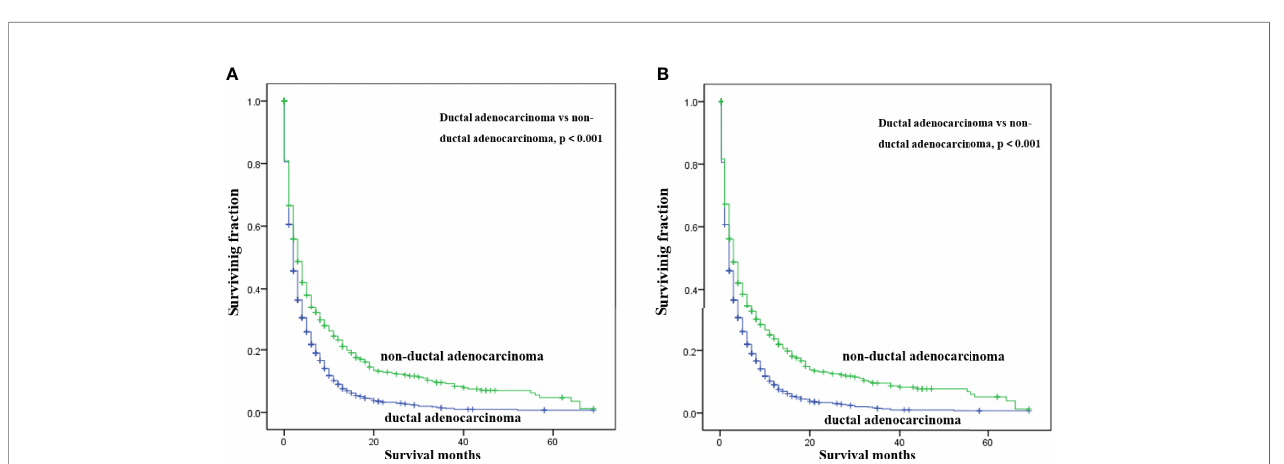
FIGURE 4 | Kaplan-Meier survival curves for estimating OS (A) and CSS (B) in patients with PCBM based on pathological type.